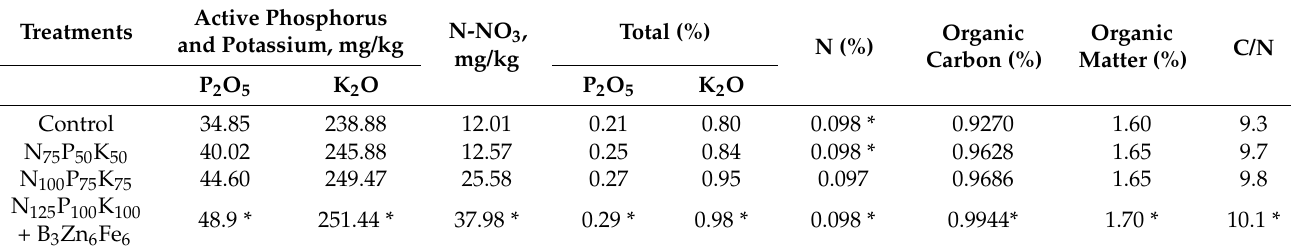
Table 5. The effect of mineral fertilisers on agrochemical properties of irrigated soil in Kibray district. Active Phosphorus Treatments